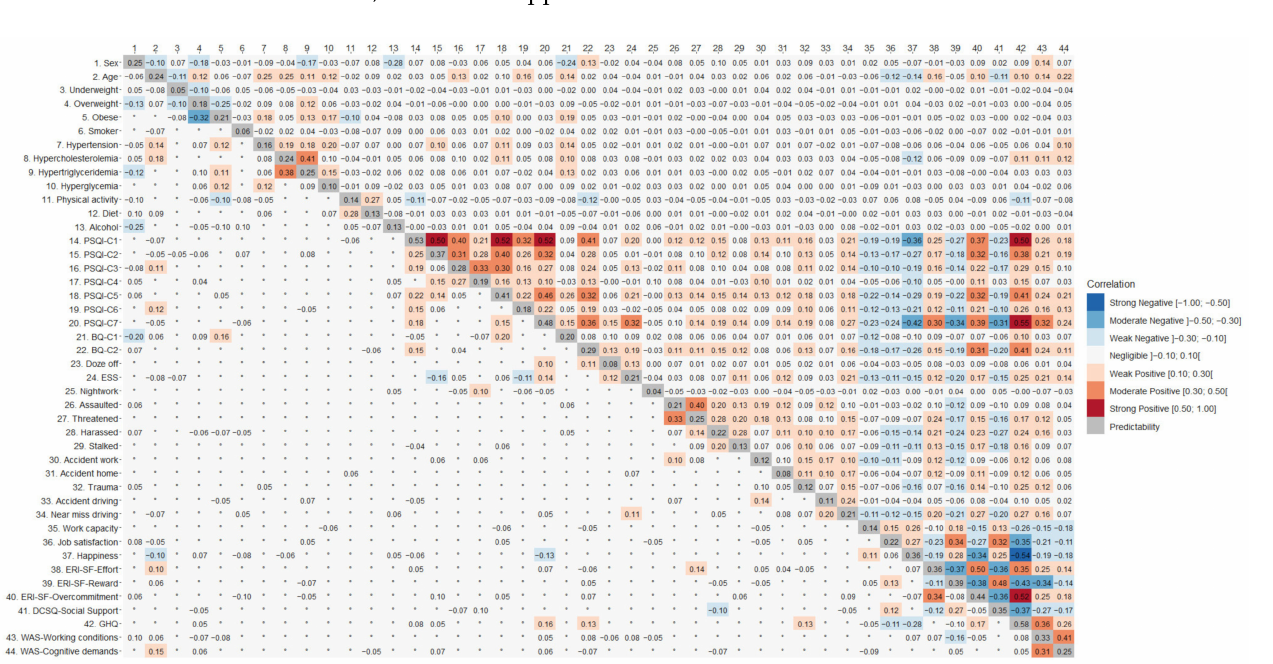
Figure 5. Correlations (upper triangle), partial correlations (lower triangle), and predictability values (diagonal) for the external validation of the Work Annoyance Scale (WAS) in Cohort 1 ( n = 2018). PSQI: Pittsburgh Sleep Quality Index; BQ: Berlin Questionnaire; ESS: Epworth Sleepiness Scale; ERI-SF: Effort-Reward Imbalance Questionnaire-Short Form; DCSQ: Demand-Control-Support Ques- tionnaire; GHQ: General Health Questionnaire. The symbol “ ◦ ” indicates a partial correlation shrunk to zero. In the legend, the outward facing brackets indicate that the value is not included in the interval, while the inward facing brackets indicate that the value is not included in the